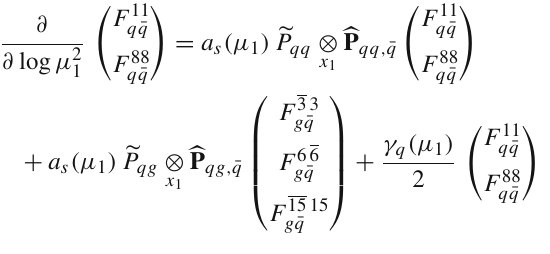
Fig. 3 The convolution x 1 x 2 P ( z ,μ) ⊗ x (9) at μ = b 0 / y = 10GeV. A weighting factor x 1 x 2 is included to keep details visible at higher momentum